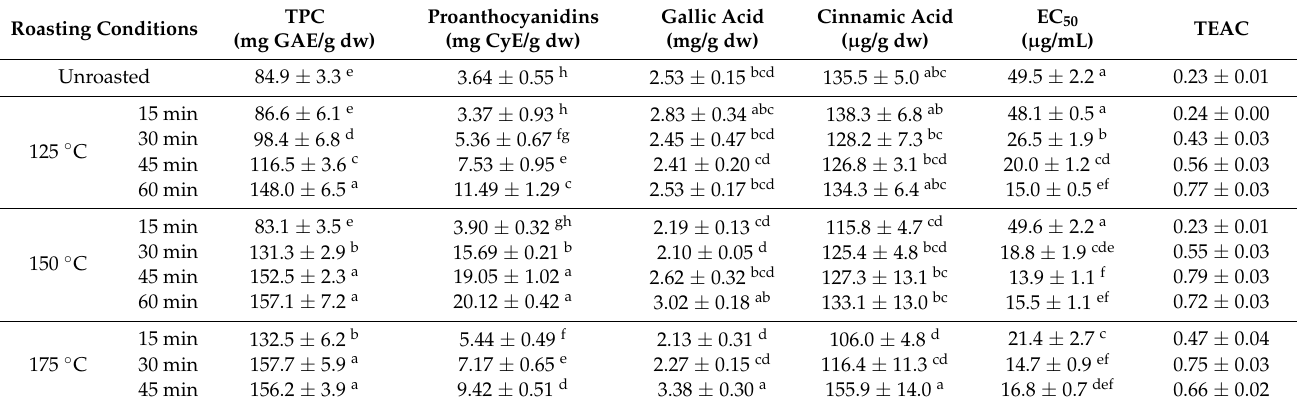
Data are presented as the mean ± standard deviation of quadruplicates. The different letters show the statistically significant differences between the roasting conditions according to Tukey’s HSD test at p <